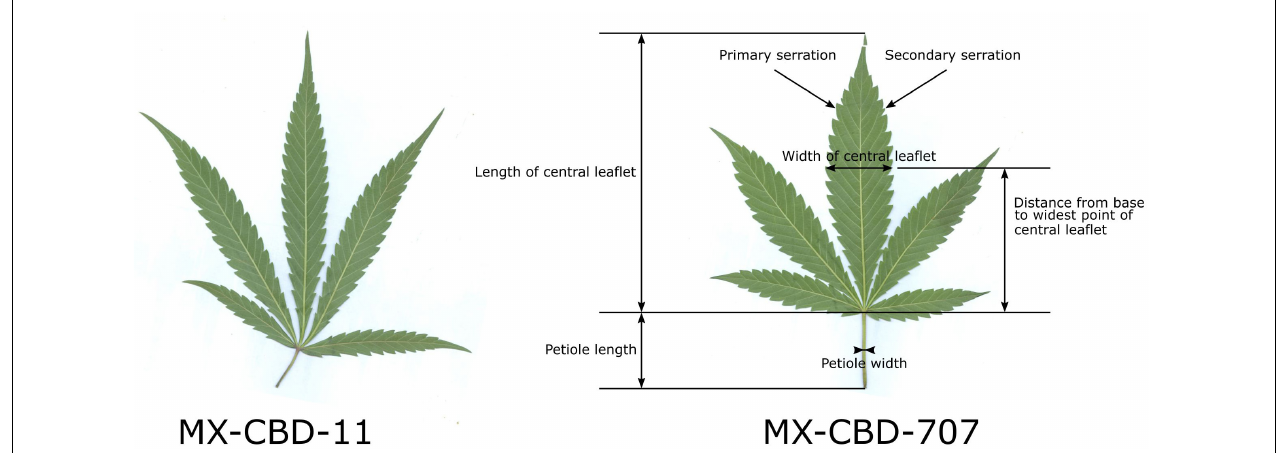
FIGURE 1 | Characteristic leaves of breeding populations MX-CBD-11 (left) and MX-CBD-707 (right) with marked leaf and central leaflet traits that were measured for all the experimental plants included in this study.